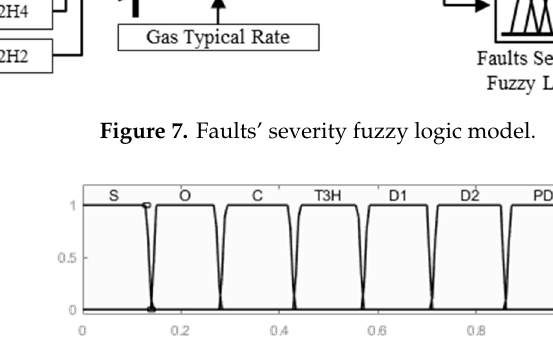
Figure 7. Faults’ severity fuzzy logic model.